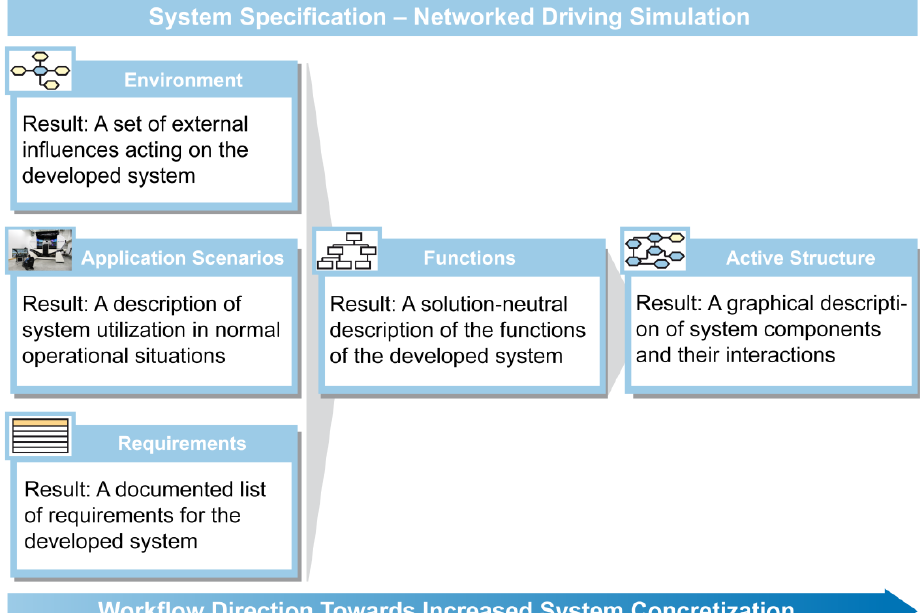
Figure 4. CONSENS workflow for networked driving simulation development.